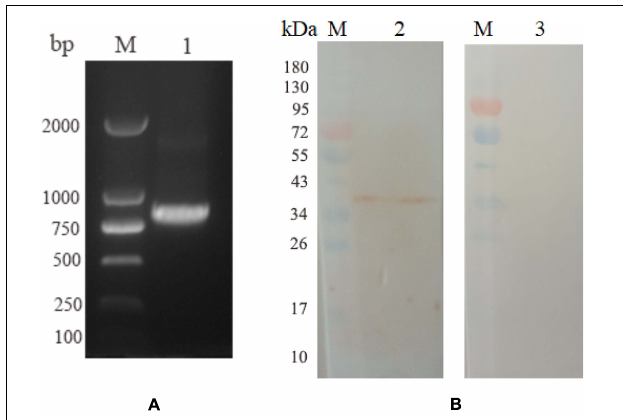
FIGURE 2 | Transcription and expression of pVAX1-EmROM3 in chickens. (A) Transcription detection of pVAX1-EmROM3 in chickens by RT-PCR. M: DNA marker DL2000. Lane 1: EmROM3 was amplified from the pVAX1-EmROM3 injected chickens. (B) Expression detection of pVAX1-EmROM3 by Western blot assay. M: protein mid-molecular weight marker. Lane 2: pVAX1-EmROM3 injected muscle recognized by the anti-rEmROM3 rat serum. Lane 3: Serum from non-injected rat was used as a negative control.